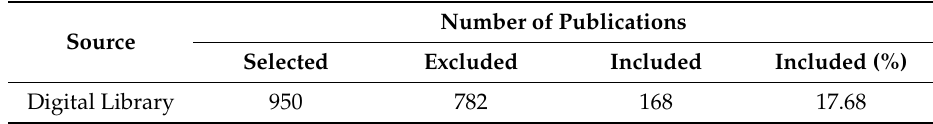
Table 2. Papers selected and included in this study.